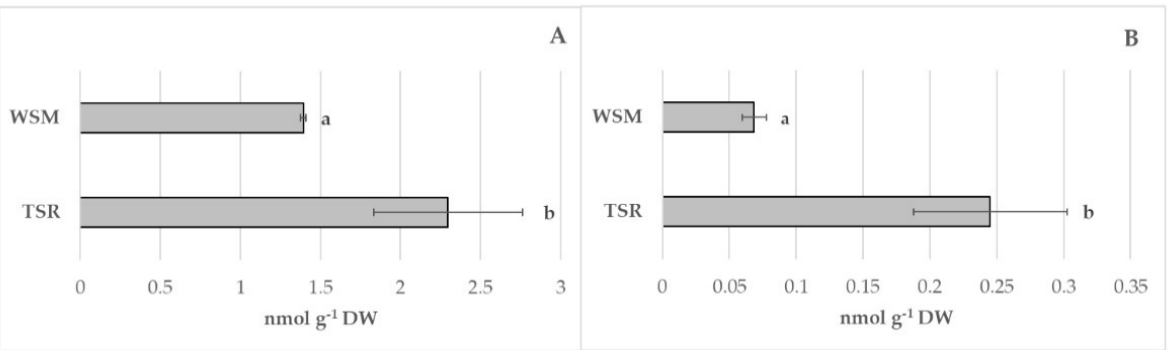
Figure 4. Polyphenoloxidase ( A ) and lypoxigenase activity ( B ) in P. eringii obtained by two different substrates (WSM and TSR). The data represent the mean values of three experiments with three technical replicates. Different letters aside the bars are significantly different according to Tukey’s test at p ≤ 0.05.